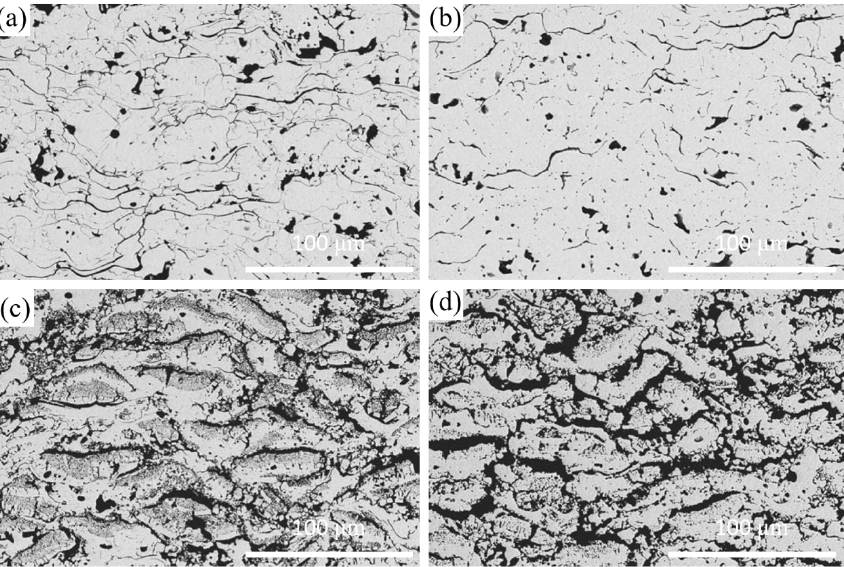
Fig. 80 Microstructural evolution of conventional and nanostructured TBCs during thermal exposure at 1400 ℃ : (a) conventional TBCs at 0 h, (b) conventional TBCs at 20 h, (c) nanostructured TBCs at 0 h, and (d) nanostructured TBCs at 20 h. Reproduced with permission from Ref. [379], © ASM International 2008.